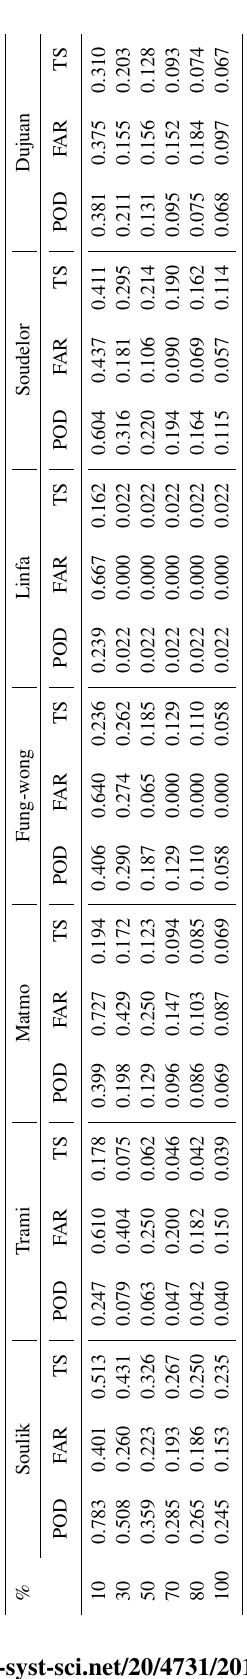
Table 7. Performance of all typhoons with the data assimilation technique for 1 to 24, 25 to 48, and 49 to 72h lead